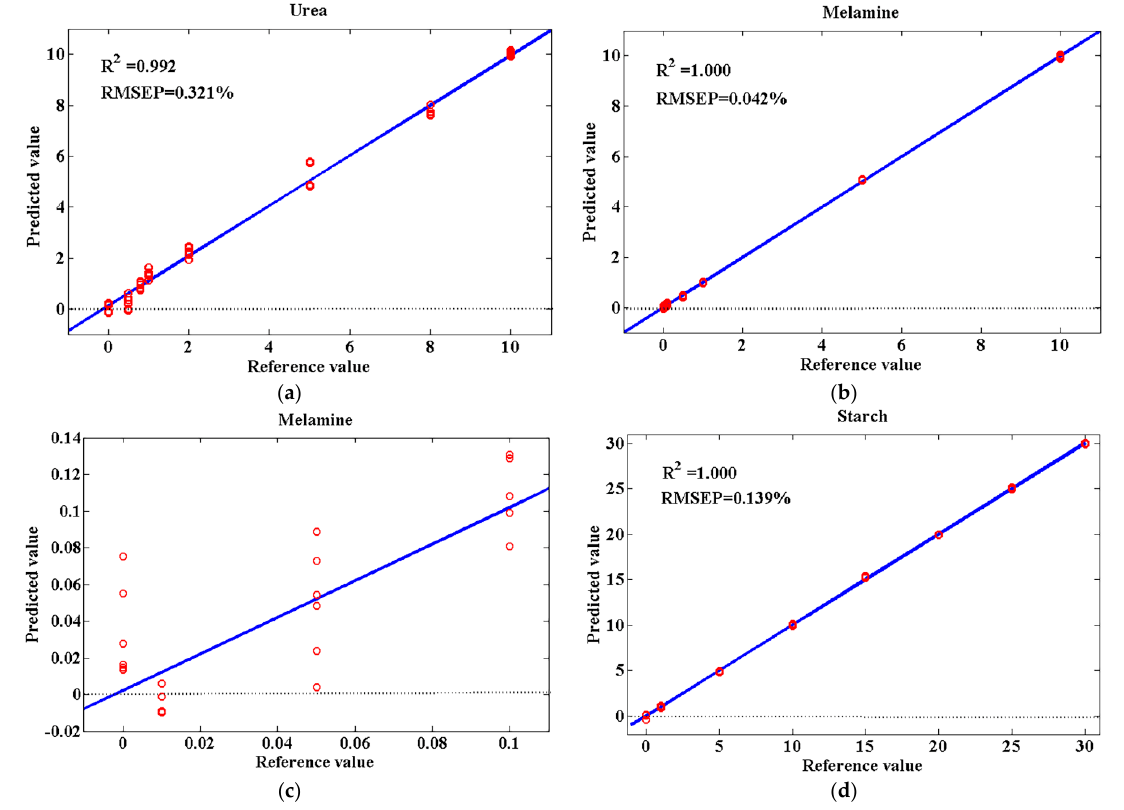
Figure 4. Predicted vs. reference plots for prediction sets of the three best full spectral PLS1 models for urea determination ( a ), melamine determination ( b ) with an enlarged view in the range of 0–0.1% ( c ), and starch determination ( d ). Table 2. Results of each adulterant in the prediction set based on the corresponding best models. Actual Value (%) Predicted Value (%) Absolute error (%) Urea Melamine Starch Urea Melamine Starch Urea Melamine Starch